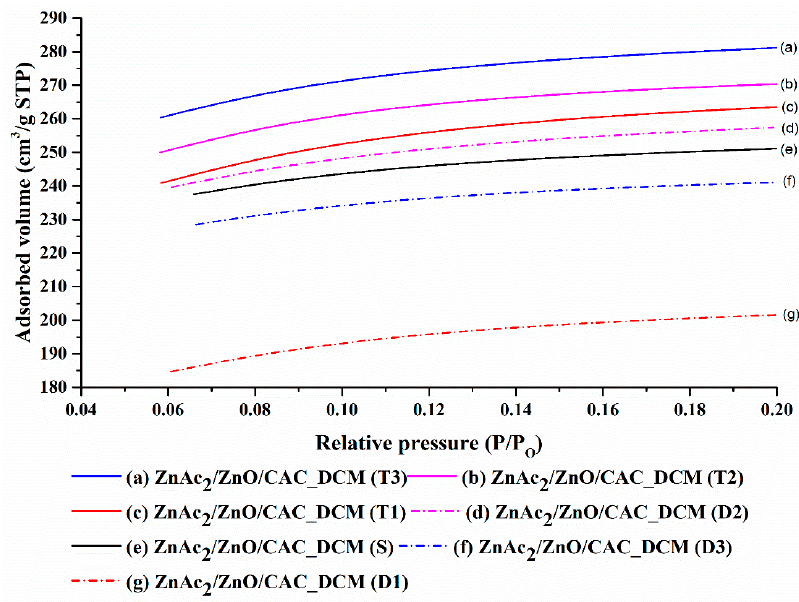
Figure 4. N 2 adsorption–desorption isotherms of ZnAc 2 /ZnO/CAC_DCM in three H 2 S adsorption– desorption cycles. Table 5. Porous properties of ZnAc 2 /ZnO/CAC_DCM in three H 2 S adsorption–desorption cycles.